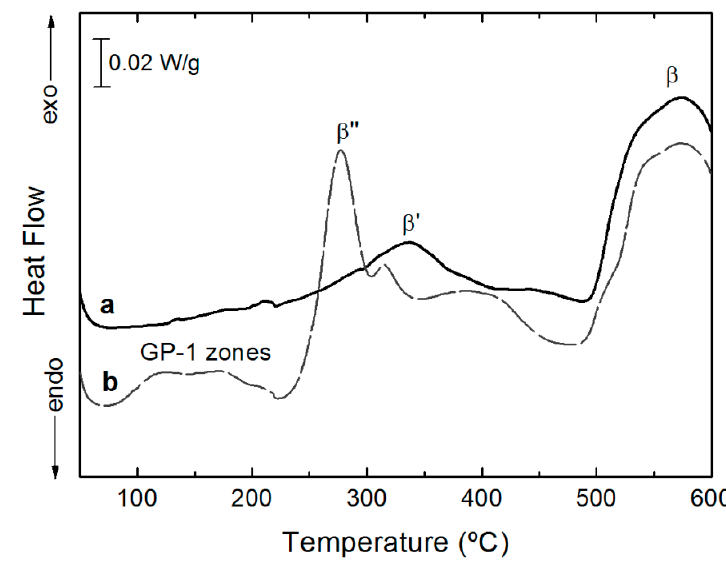
Figure 6. Differential scanning calorimetry (DSC) curves of the AA 6005A powders extruded at 500 ° C from AA 6005A compacted powders solution treated at 530 ° C and quenched a and untreated b.